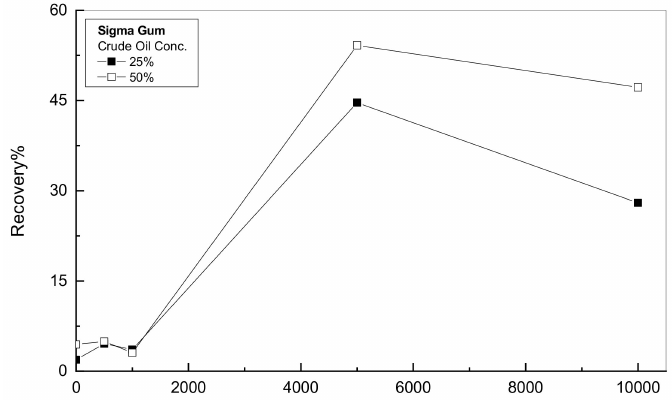
Figure 5. Recovery behavior for crude oil-Sigma